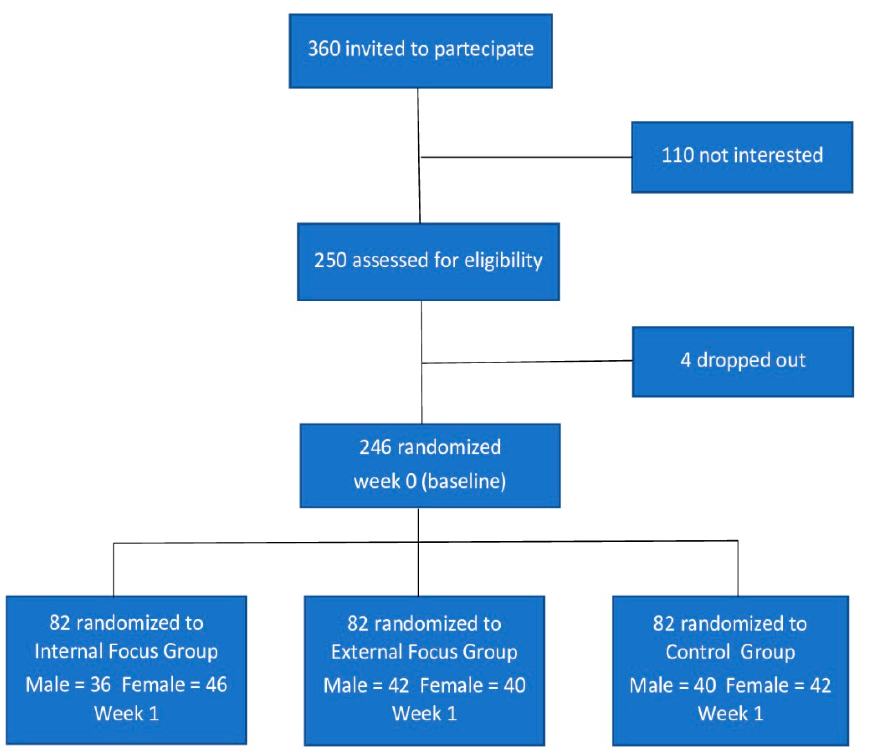
Figure 1. Consort diagram of trial enrollment and flow of the study.